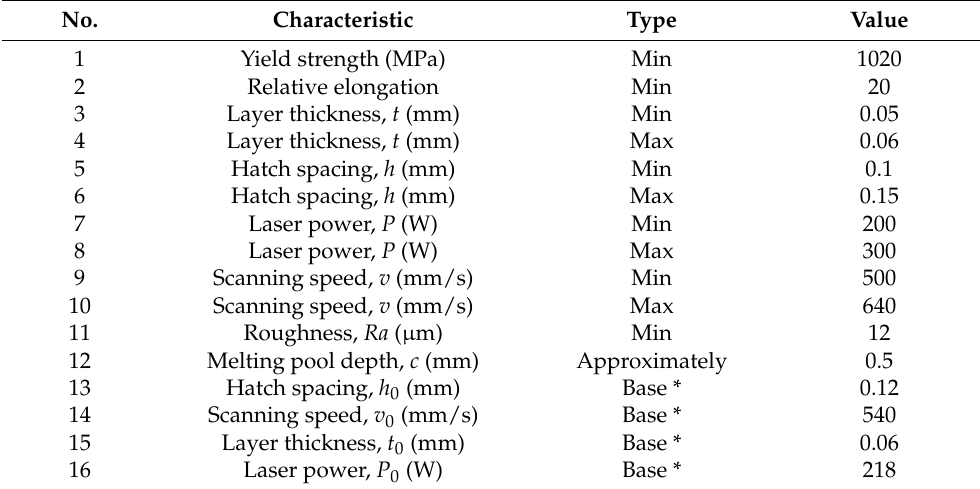
Table 6. Data for the formation of the area of limitations.